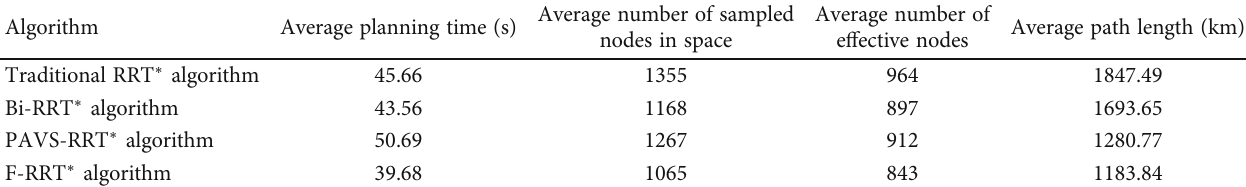
Table 1: Comparative performance analysis of various RRT ∗